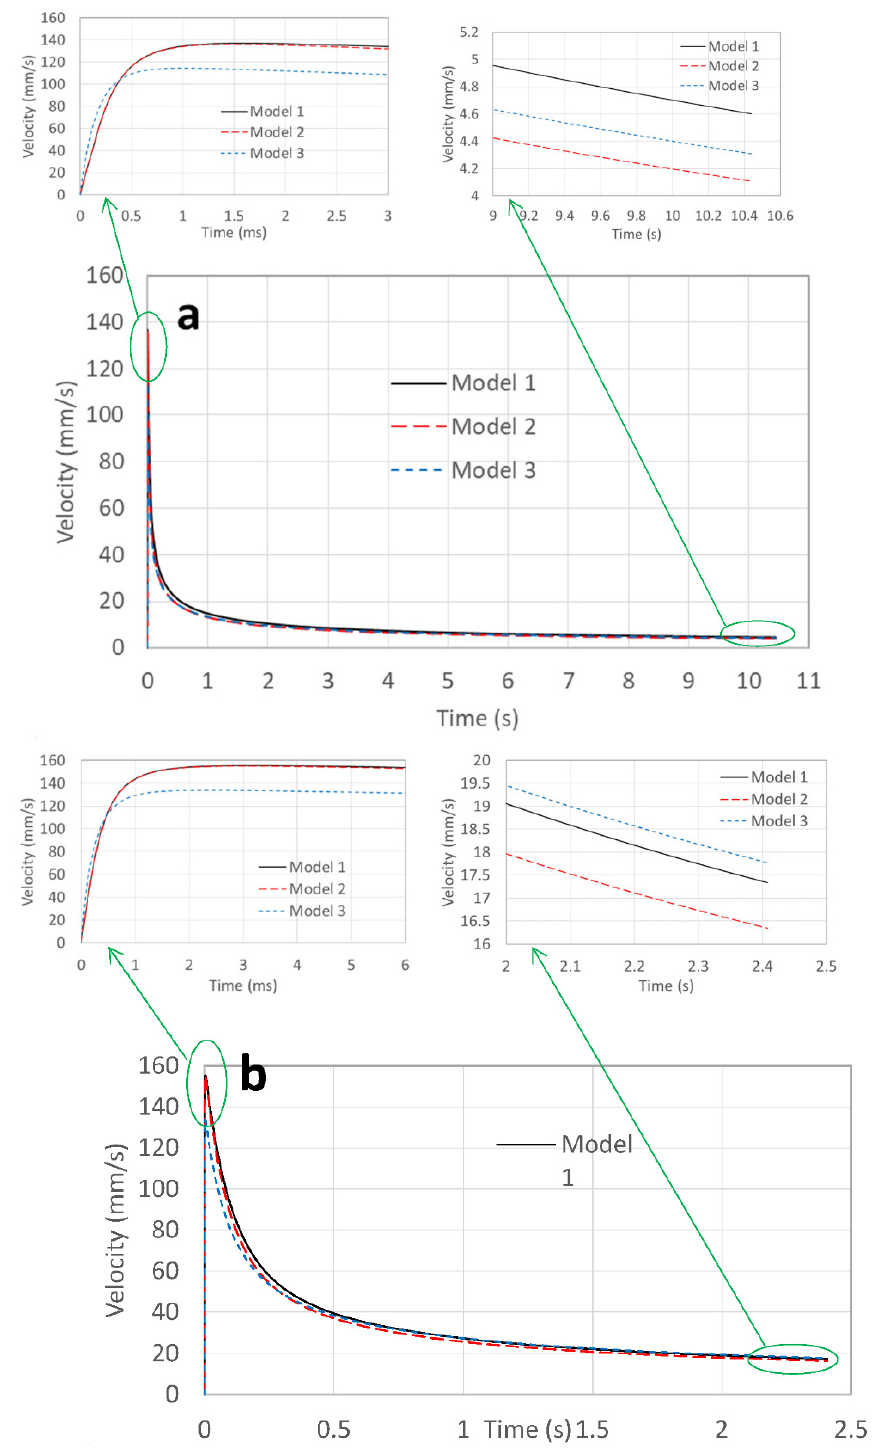
Figure 4. Filling speed versus time in the tube filling process. Here, ( a ) and ( b ) indicate tubes 0.5 and 1.15 mm in diameter, respectively.